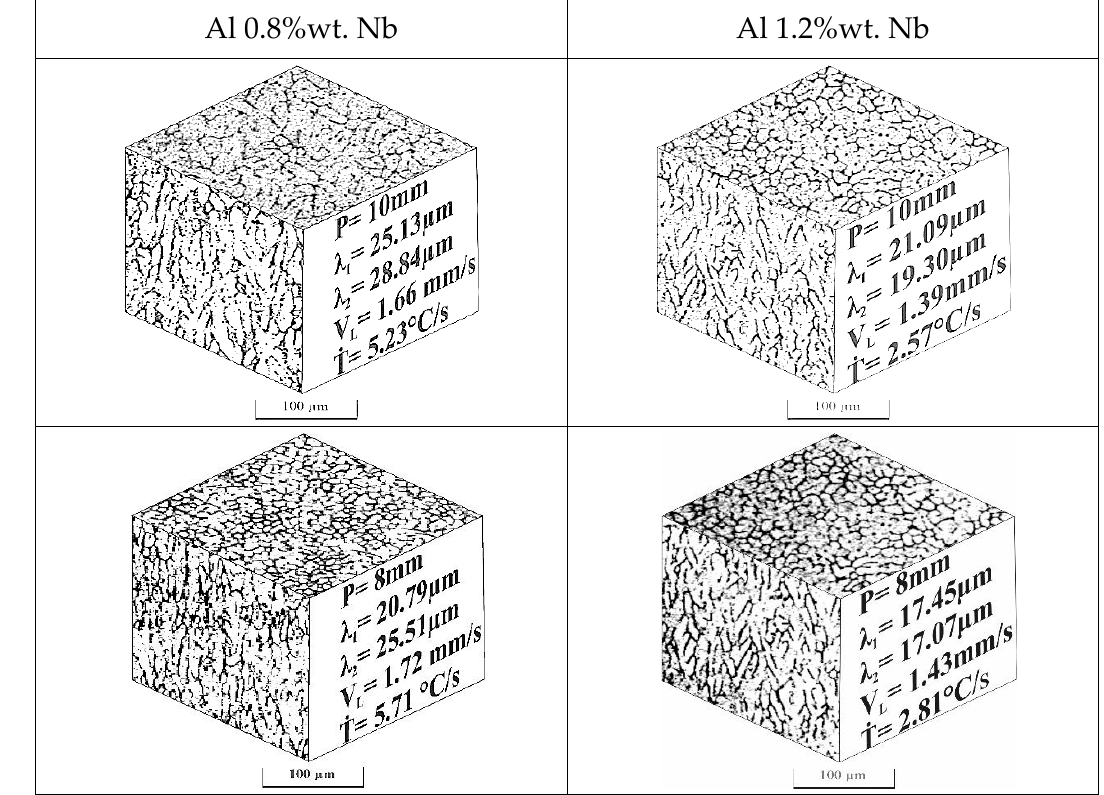
Figure 7. Typical solidification microstructures along the transverse ( λ 1 ) and longitudinal sections ( λ 2 ) of Al–0.8 Nb and Al–1.2 Nb (wt.%) alloys at the metal/mold interface 35 and 27 mm.